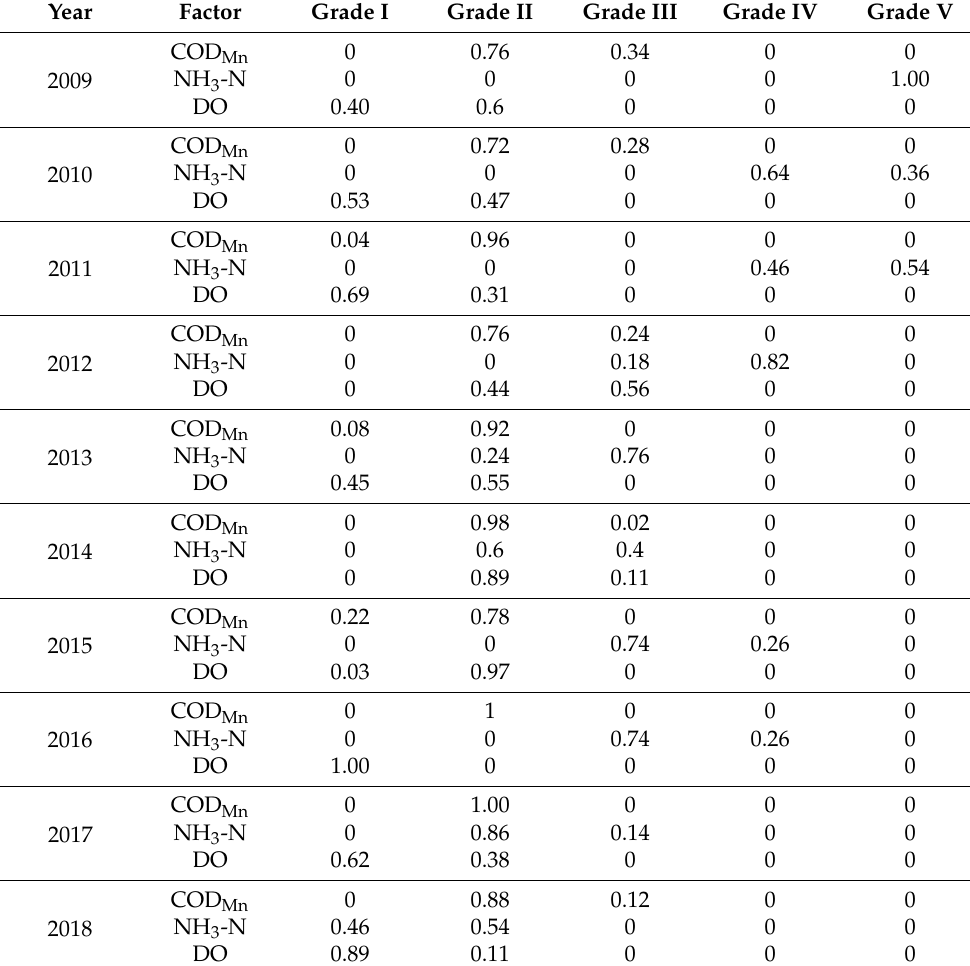
Table A8. Fuzzy matrix of Jishuigang Station in Qingpu,